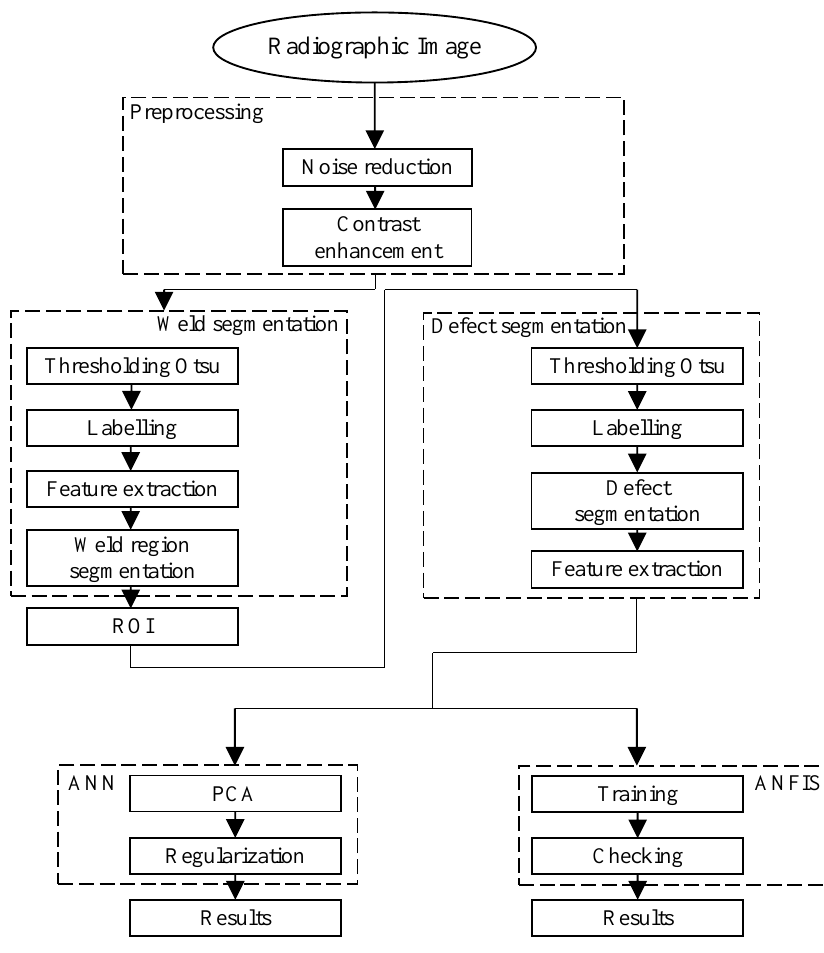
Figure 1. Procedure of automatic welding defect detection system